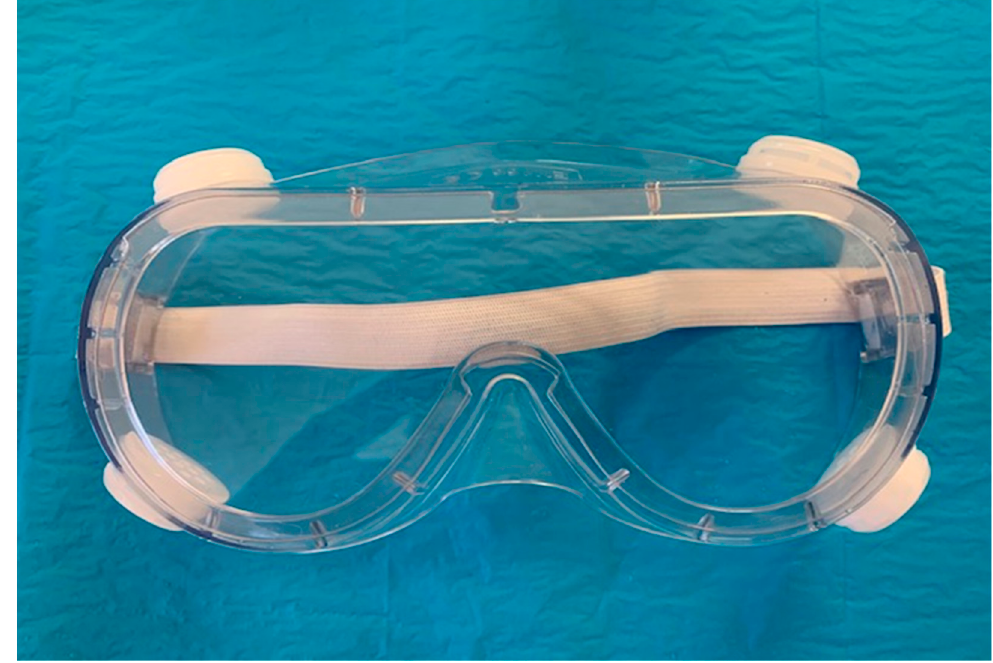
Figure 7. Eye protection glasses.